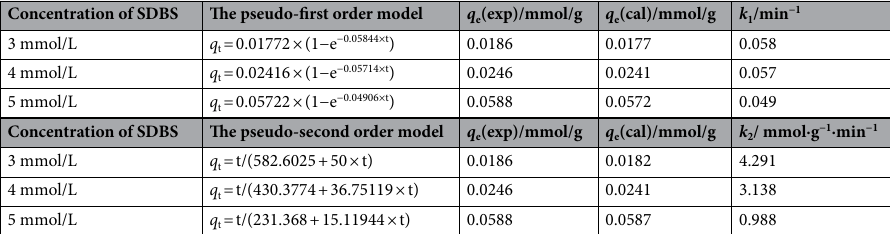
Table 2. Fitting results of pseudo-first order and pseudo-second order model at different concentrations.